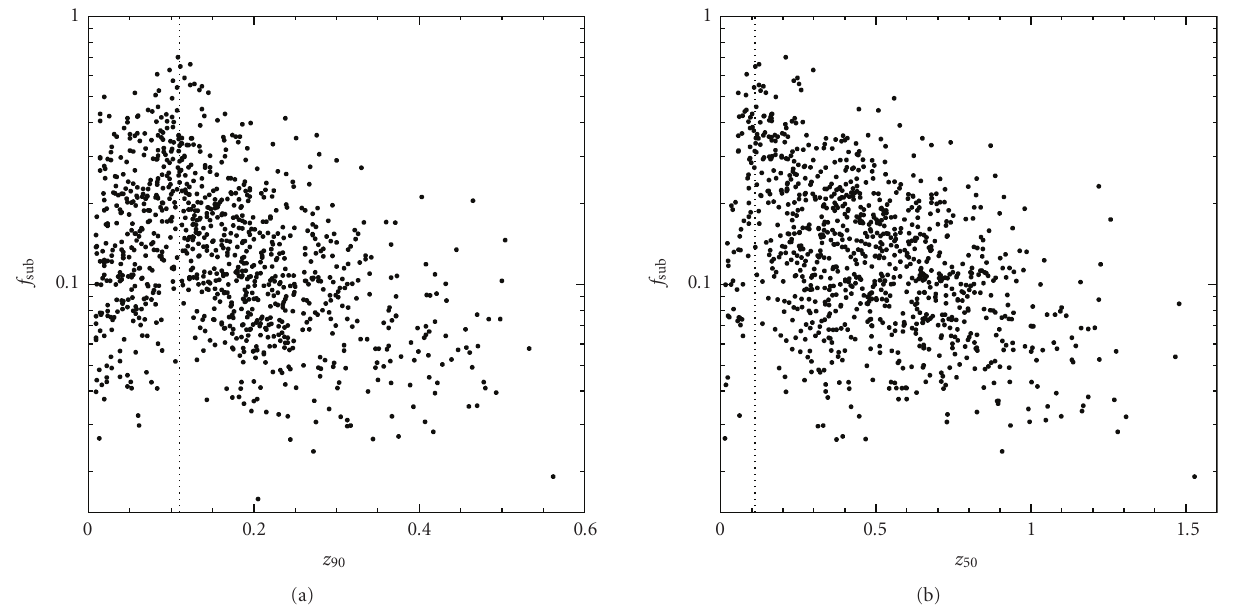
Figure 6: Lensing substructure fraction versus the formation reshifts z 90 (a) and z 50 (b). The dotted line indicates the epoch approximately one infall time before